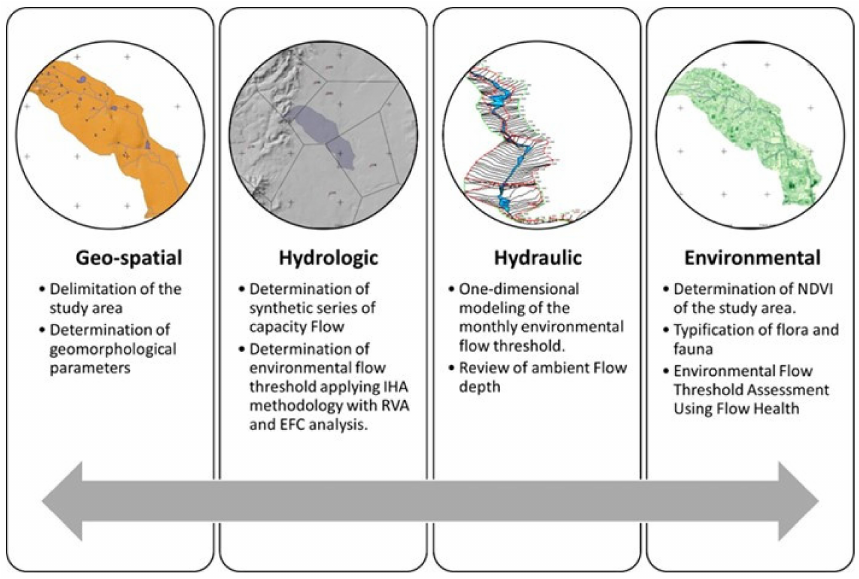
Figure 2. Descriptive scheme of the global methodology, describing the activities performed in each of the four stages that define the core